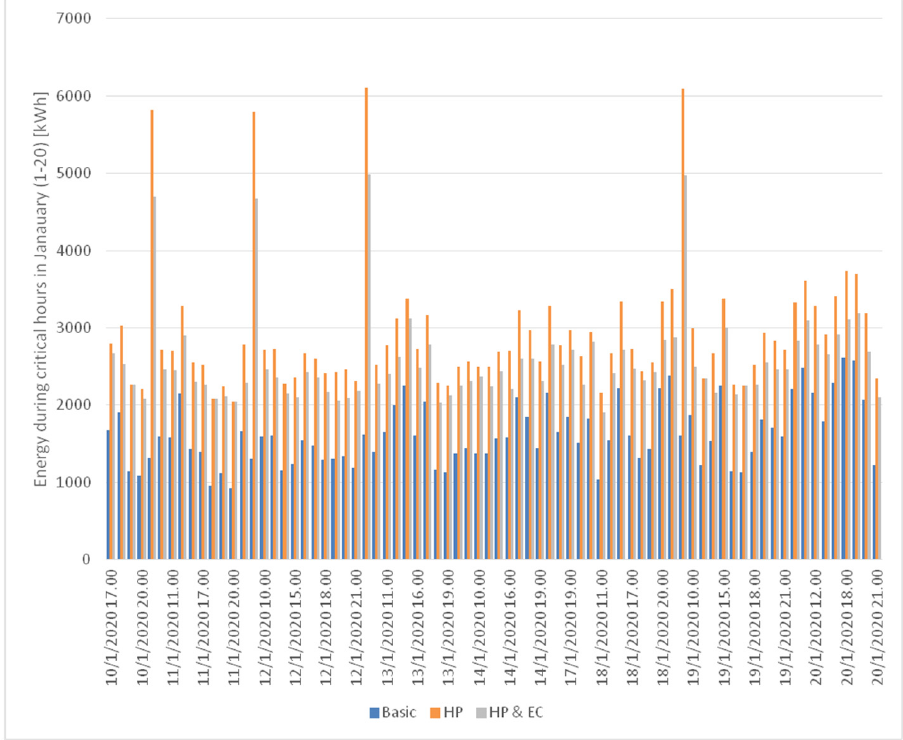
Figure 6. Comparison of pre- and postintervention: critical hours from 1 to 20 January.